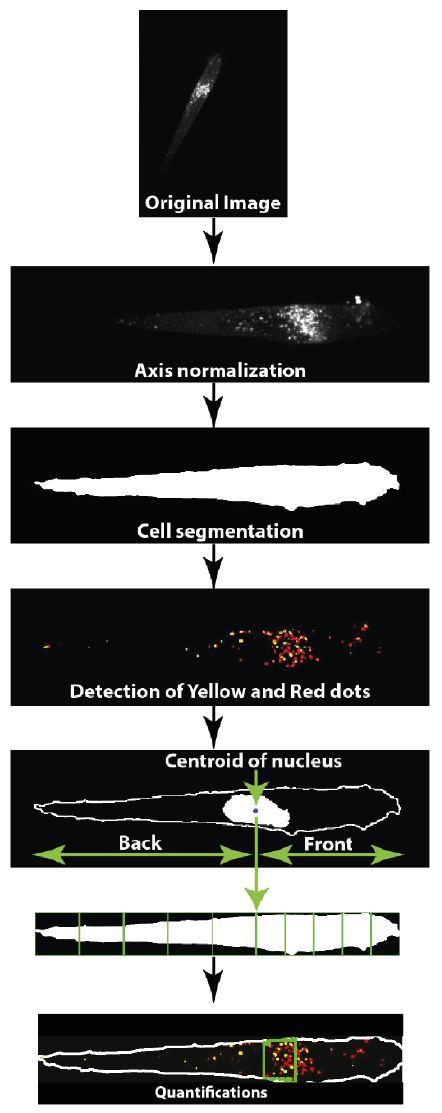
Figure 4. Image analysis workflow of TopoAutophagy computational tool. Images were acquired in four channels: GFP and RFP (for autophagy reporter), far-red (for nuclear staining), and transmission. Axis normalization was performed by aligning the cell along the x -axis. Cells were segmented using the whole cell GFP or RFP fluorescence. LC3 compartments were detected in GFP and RFP channels, yellow (red + green) dots corresponding to autophagosomes and red only dots corresponding to autolysosomes. The cen- troid of the nucleus was measured, and then the cell was partitioned in 10 vertical portions—5 equal portions from nucleus centroid to back cell edge and 5 equal portions from nucleus centroid to front cell edge—for each time point. Yellow and red dots in each cell portion were counted.